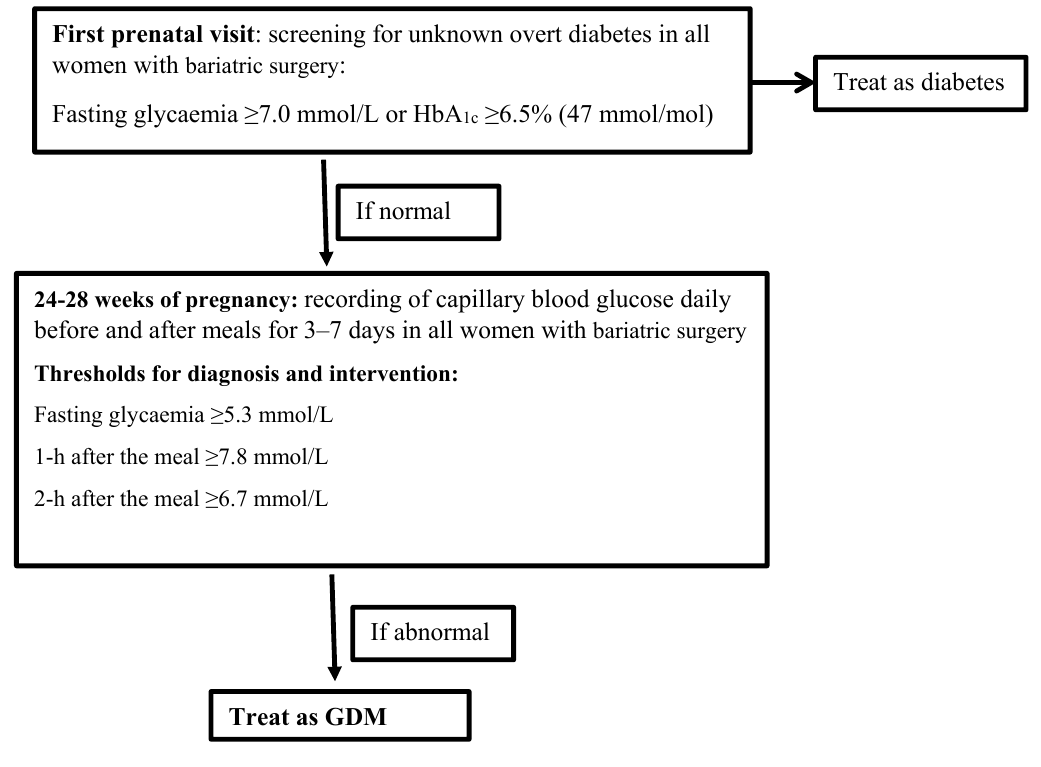
Figure 1. A pragmatic proposal for the evaluation of dysglycaemia in pregnant women after bariatric surgery. GDM: gestational diabetes